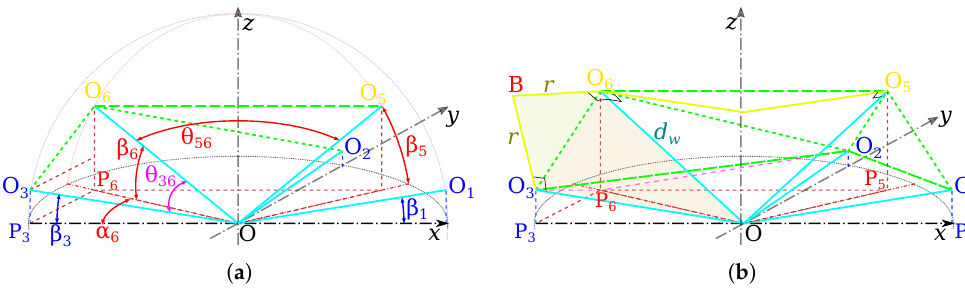
Figure 7. Representations of ( a ) the angles and ( b ) lengths’ definitions. To determine the maximum value r max for every angle β i and β j , let us define the projection P e of the center O e of the electromagnet e in the xy -plane, as represented in Figure 7a. As one can see, each angle θ ij is defined as: with the length d ij = O i O j =